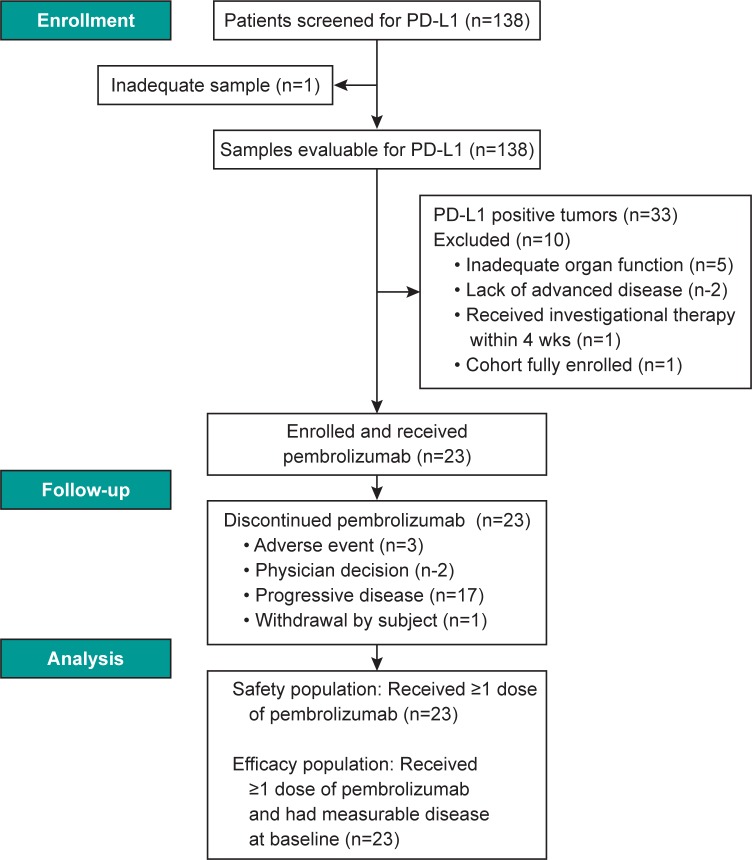
CONSORT diagram.